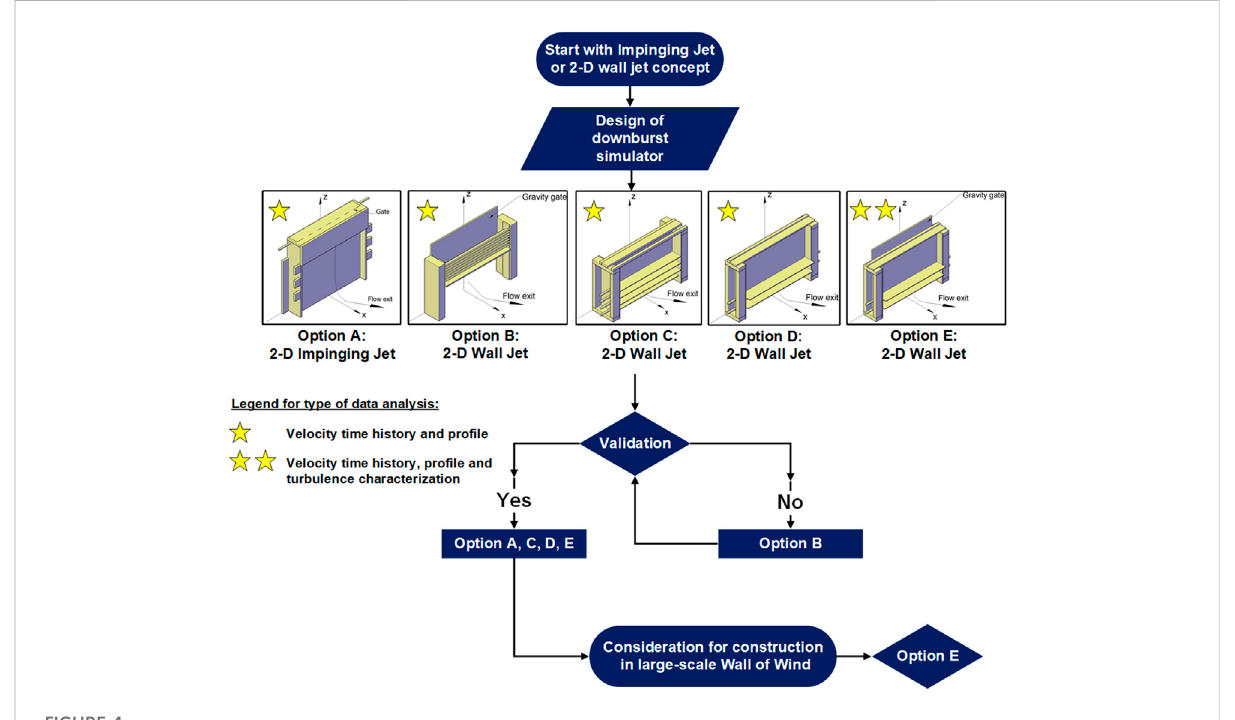
FIGURE 4 Schematic summary layout of the downburst simulation design process and